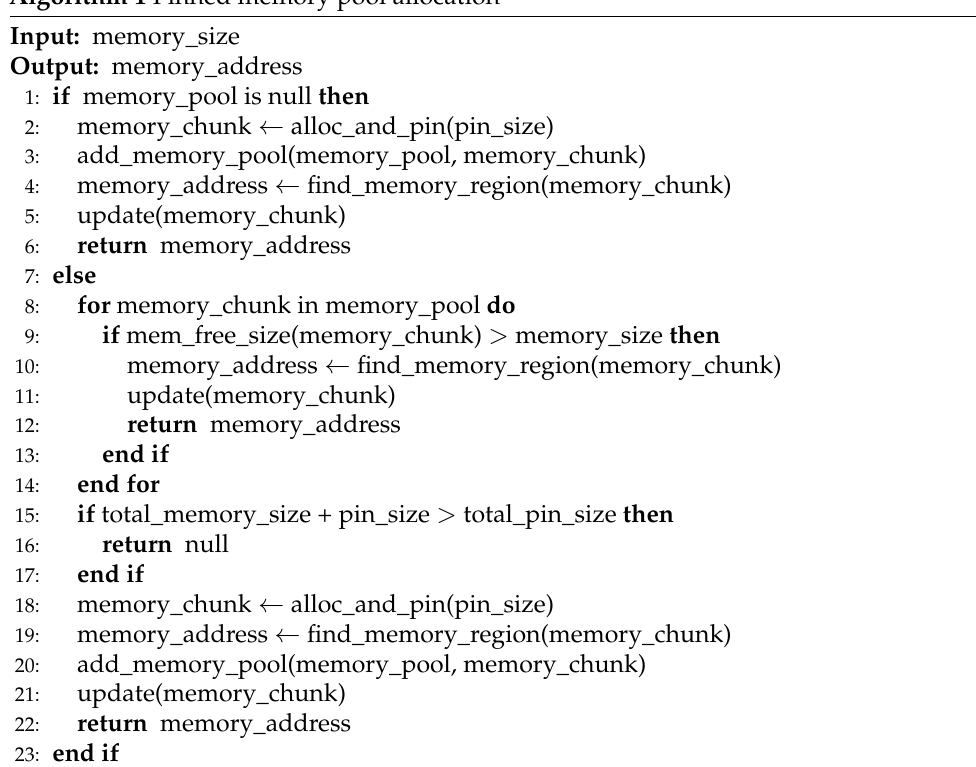
Algorithm 1 Pinned memory pool